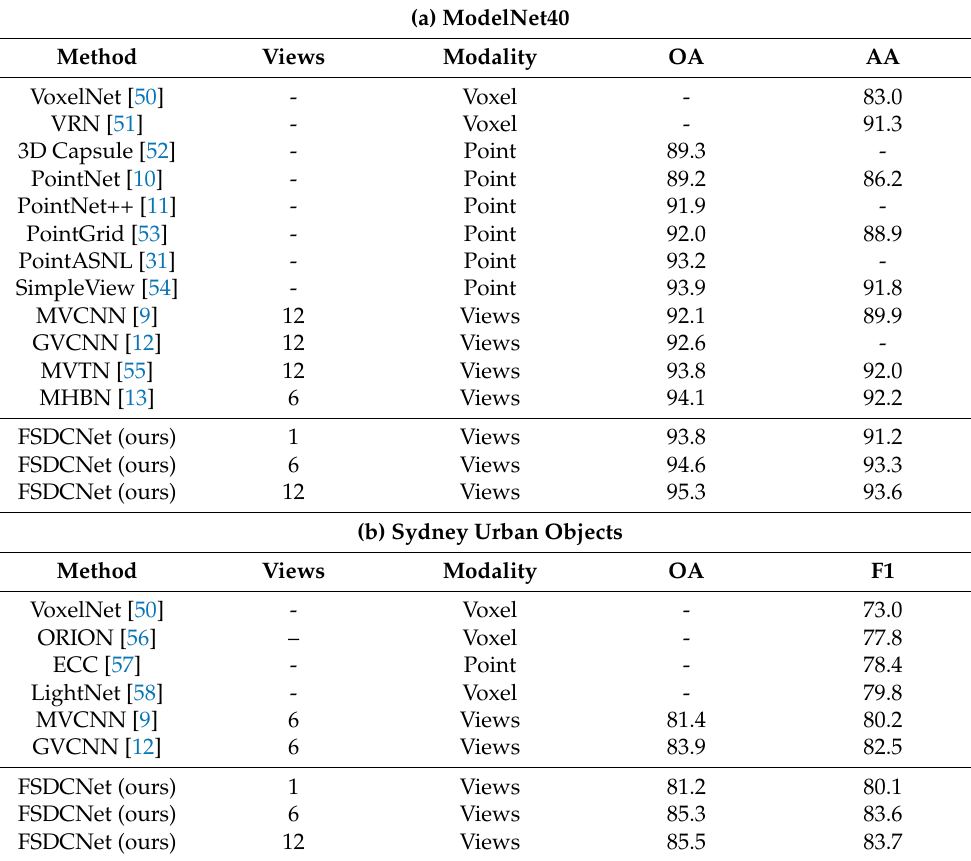
Table 2. Performance comparison of classification algorithms based on the ModelNet40 and Sydney Urban Objects